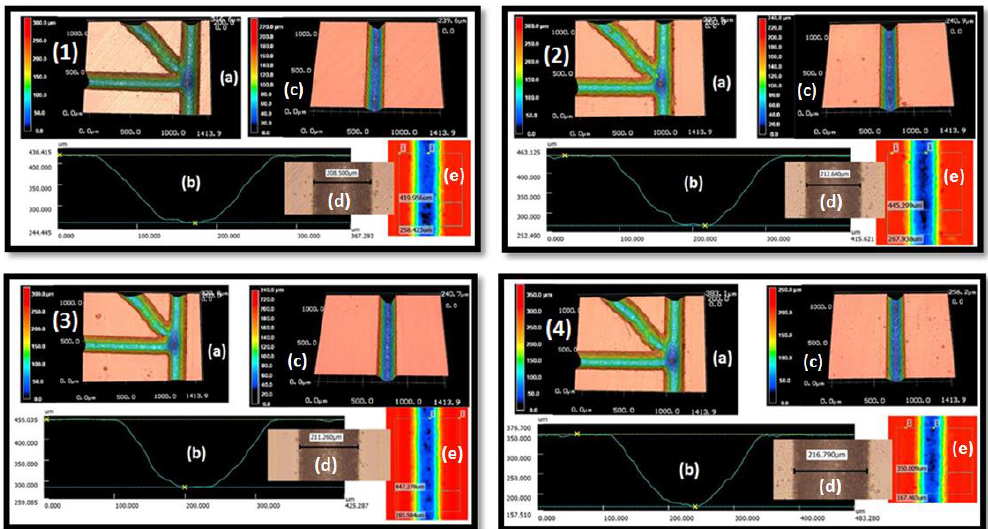
Figure 3. Repeatability of the manufacturing. Four different manufacturing samples (1 – 4). ( a ) 3D projection of the channel at the cross region, ( b ) Channel profile, ( c ) 3D projection of the main channel, ( d ) surface width of the channel and ( e ) colored photo to show width and depth. Sample 1 surface width 208 μm , Sample 2: surface width 212 μm , Sample 3: surface width 211 μm and Sample 4: surface width 216 μm .